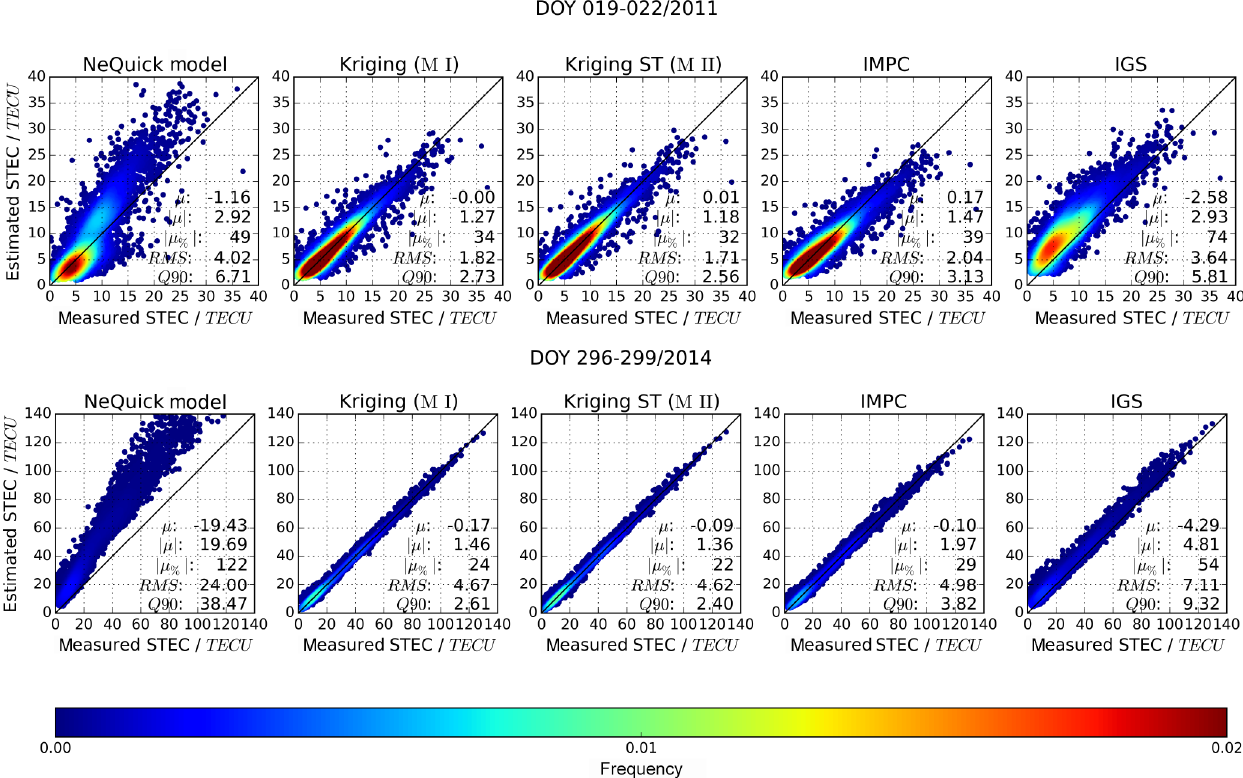
Figure 3. Cross-validation of STEC estimated by the NeQuick model, the kriging with spatial covariance MI, the kriging with spatial– temporal covariance MII, the IMPC TEC maps and the IGS TEC maps (from left to right) at the four IGS validation stations “ieng”, “mad2”, “pots”, and “spt0” for DOY 019–022/2011 (top row) and DOY 296–299/2014 (bottom row).